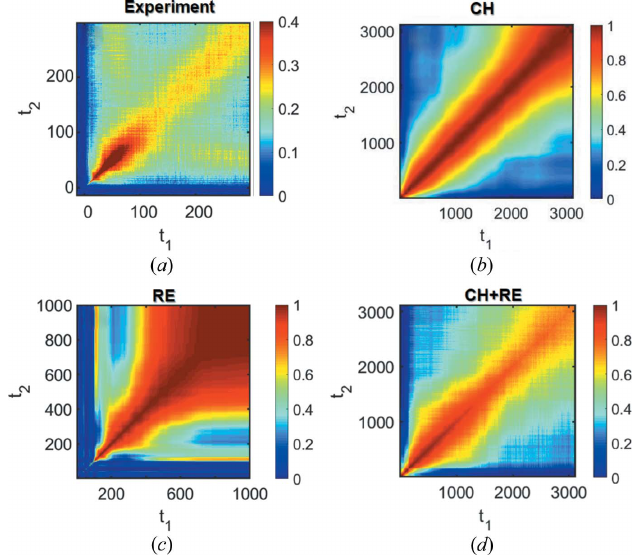
Figure 7 ( a ) Experimental TTC. ( b ) TTC obtained from the CH simulation. ( c ) An example of a TTC that is possible to obtain by RE with simple models (see Fig. S10). ( d ) ATTC obtained by modification of the evolution of the system by the CH equation with ideas (CH + RE) revealed from the RE. The ratio of speeds of growth in the early stage and dissolution in the coarsening stage was increased, which made the square feature more pronounced. Furthermore, the noise of 4% was added, which resulted in a change of the contrast along the diagonal similar to the experimental